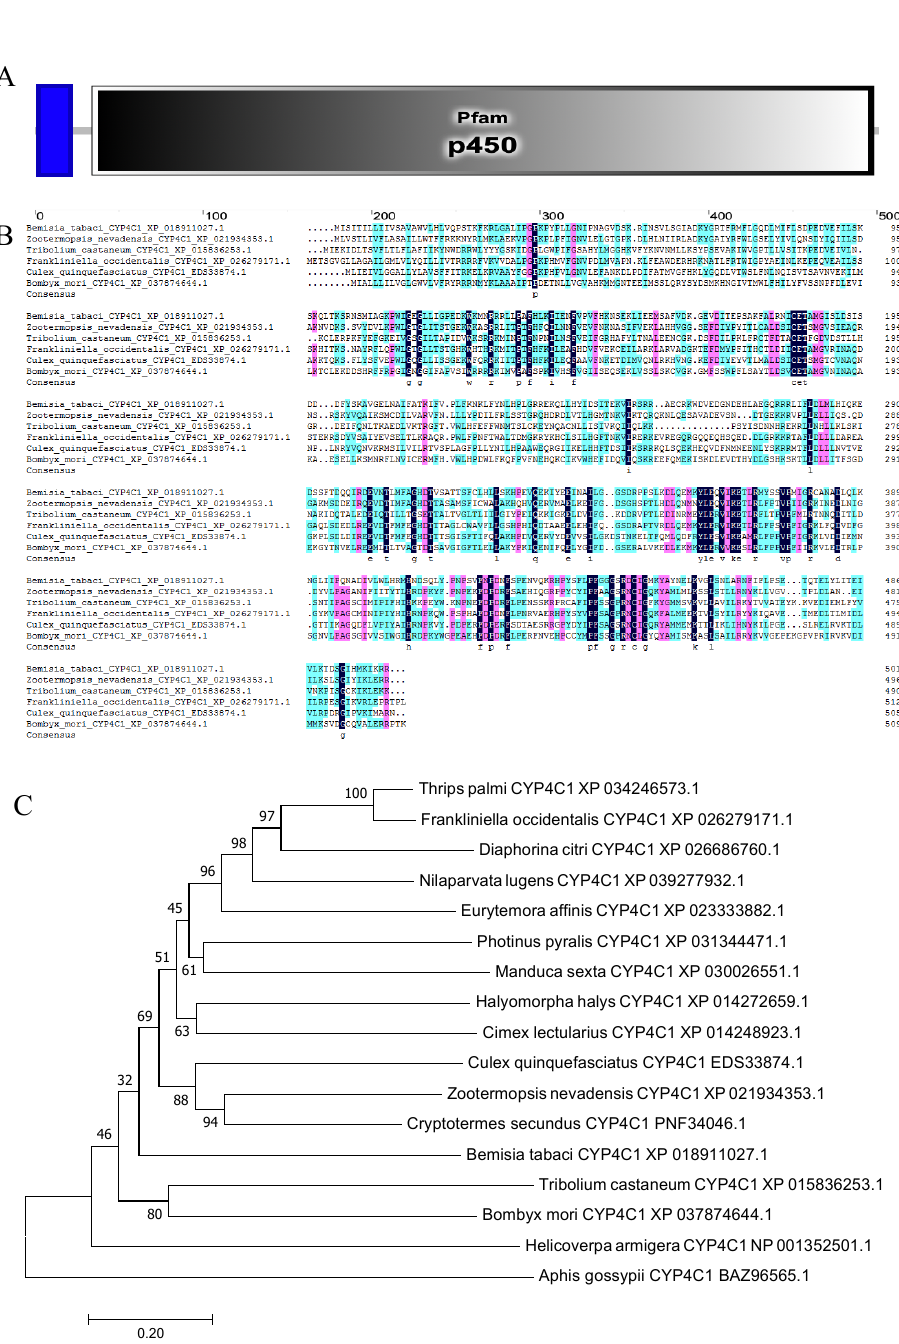
Figure 1. ( A ) The functional domain of BtCYP 4C1 . ( B ) The multiple alignment of the deduced amino acids of CYP 4C1 in Bemisia tabaci . ( C ) Phylogenetic analysis based on amino acid Scheme 4 C1 .